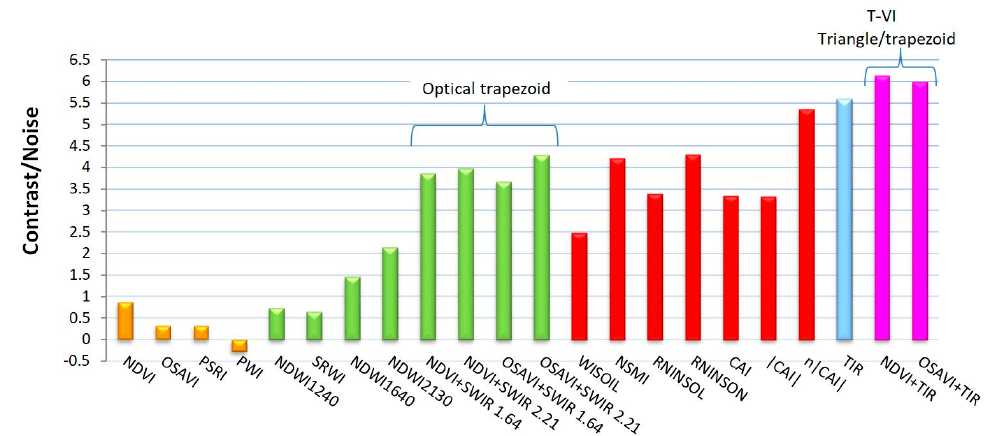
Figure 6. Contrast ‐ to ‐ noise (C/N) ratio when comparing the signal over the “wet” area and the reference “dry” area. The information is extracted from index maps based on optical signals (reflectance) in the VNIR spectrum (orange bars), in the VNIR + SWIR spectra (green bars), in the SWIR spectrum alone (red bars), or from the raw thermal infrared signal (TIR) radiance temperature (blue bar), or by combining VNIR + TIR spectra as in the T ‐ VI Triangle/Trapezoid Method (purple bars). Same colors as in Figure 3.